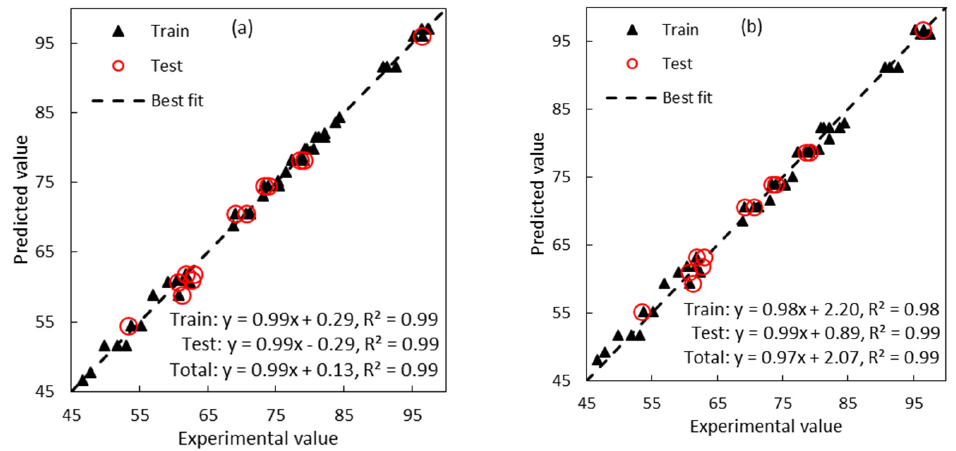
Figure 3. Predicted vs. actual data obtained from ( a ) MLP and ( b ) SVM models.